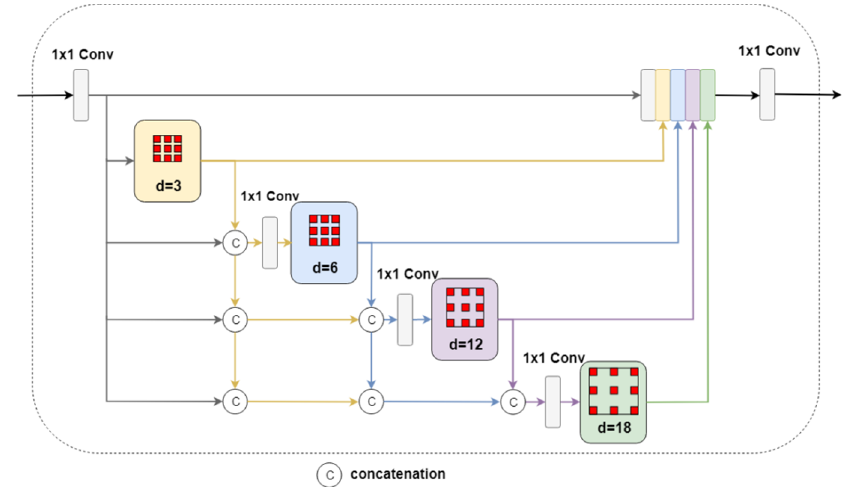
Figure 4. The local module. The output of each dilated convolutional layer is concatenated with the input feature map and convolved with 1 × 1 convolution to maintain fixed channel number before going into the next dilated convolution layer.